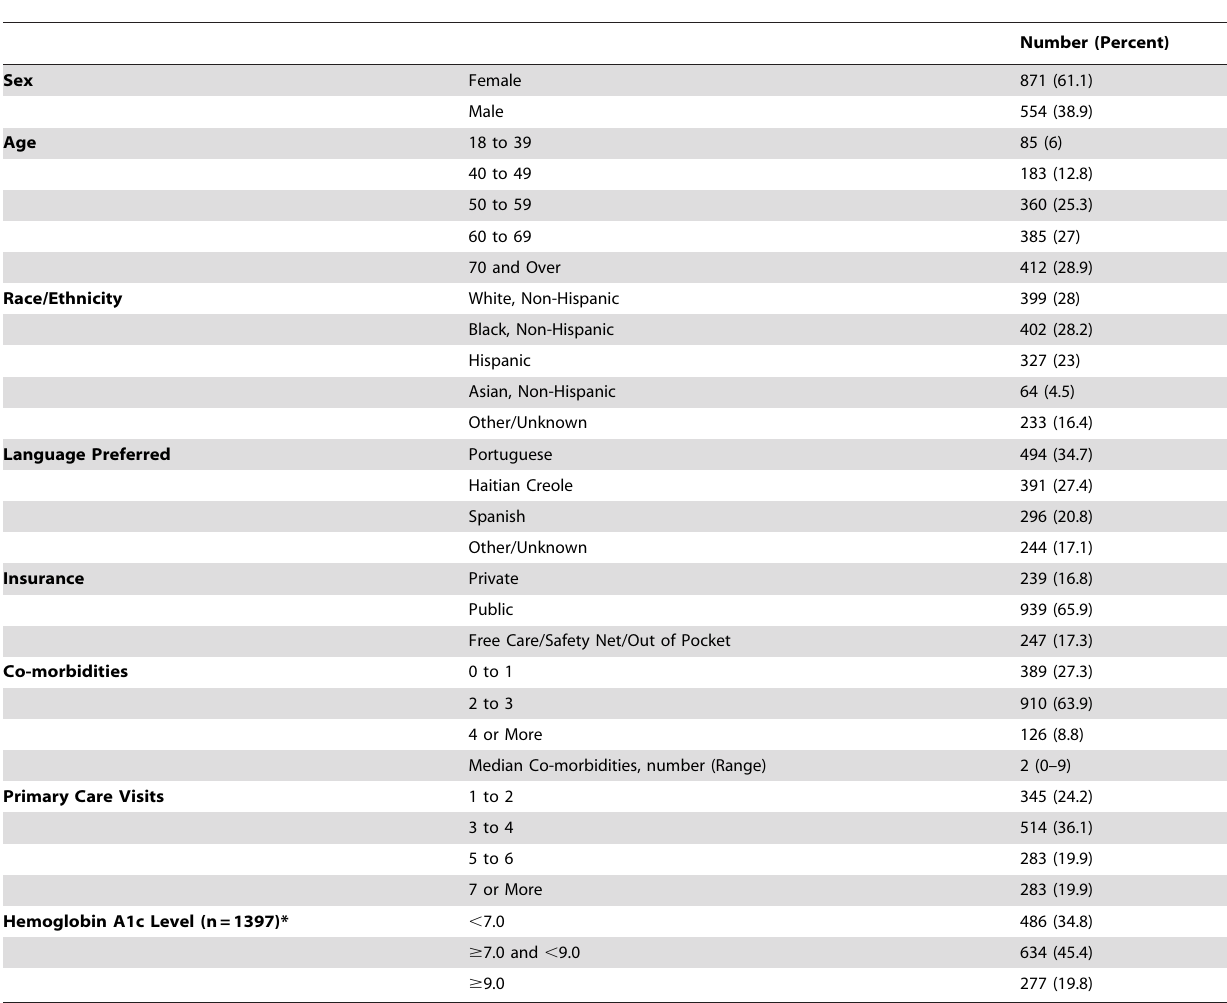
Table 1. Demographic and Clinical Characteristics of Limited English Proficient Population N